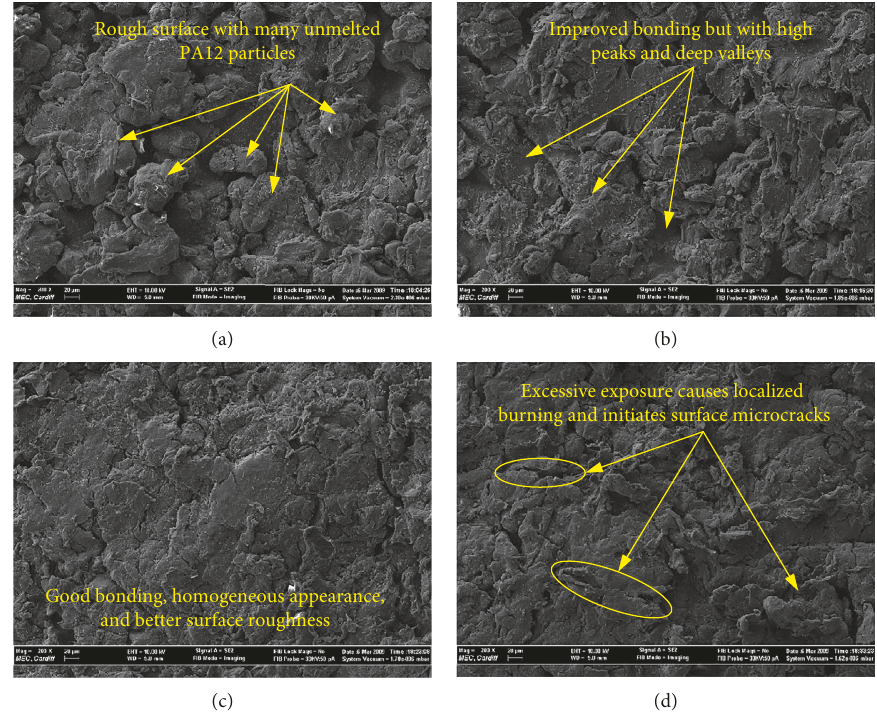
Figure 11: Effect of laser power on surface topography of SLS parts: (a) LP � 4.5 watt; (b) LP � 6.0watt; (c) LP � 7.0watt; (d) LP �